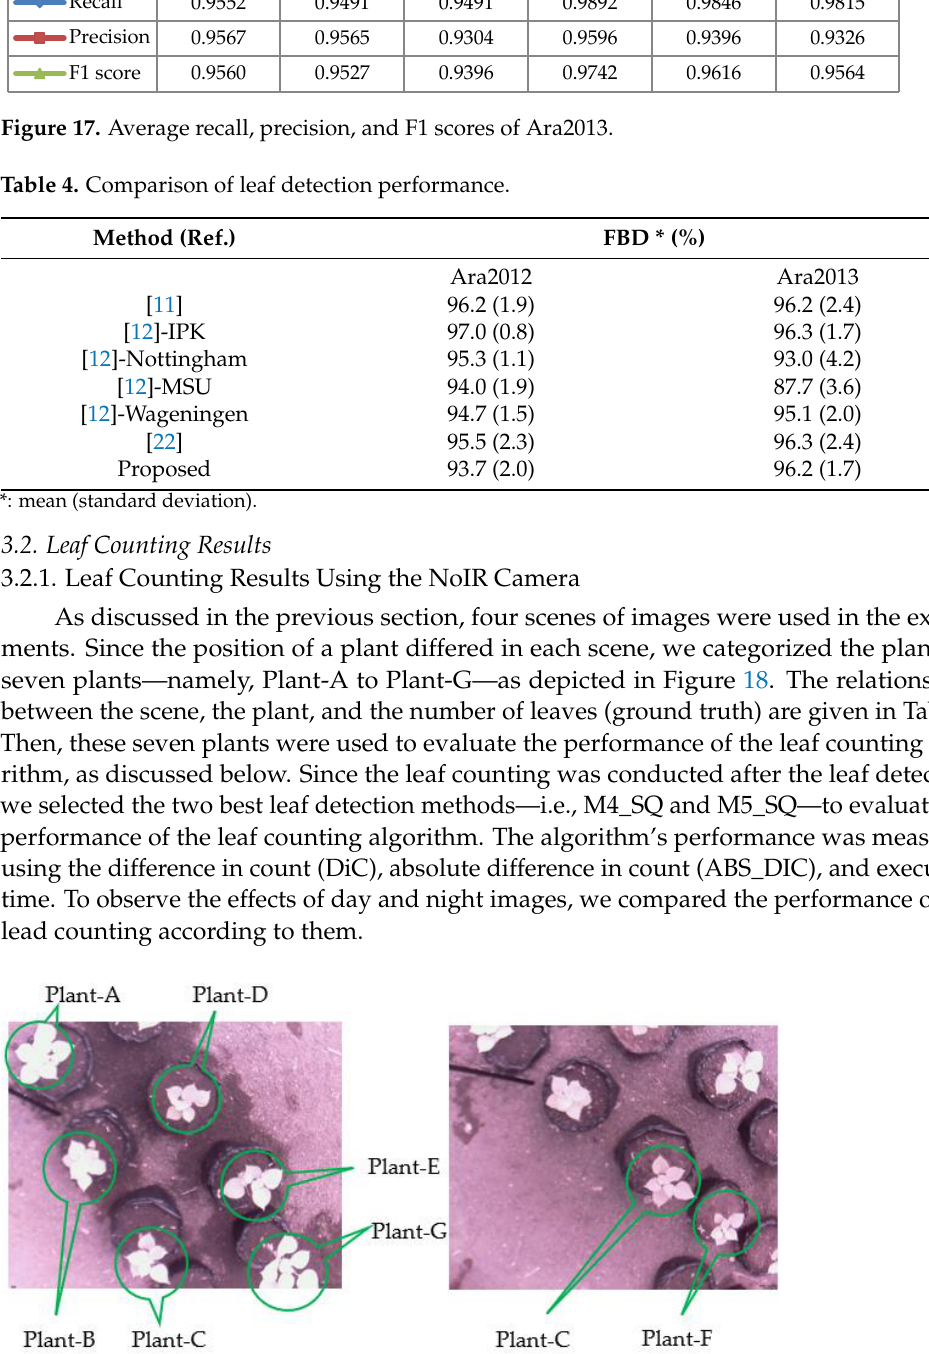
Figure 18. Position of Plant-A to Plant-G in the leaf counting experiments. Table 5. Relationships between the scene, plant, and number of